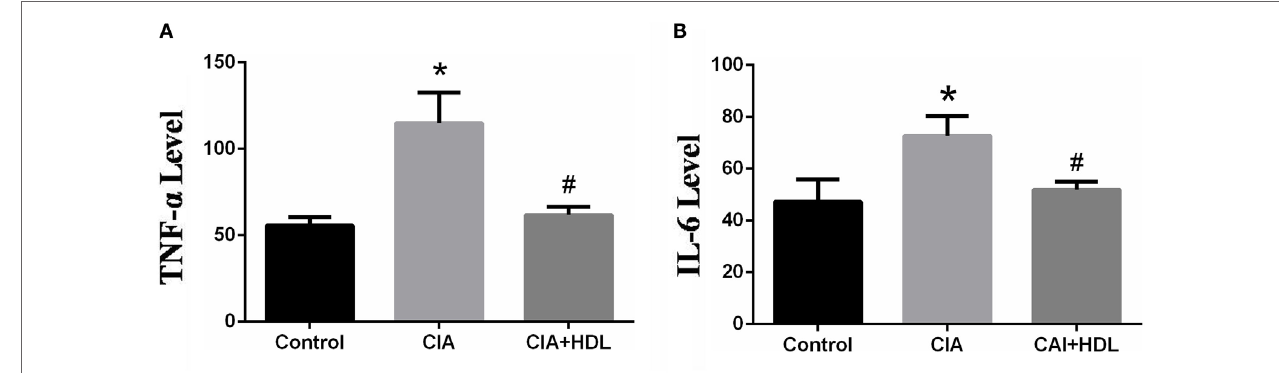
FigUre 2 | (a) The expression of tumor necrosis factor-alpha (TNF- α ) in serum; (B) the expression of IL-6 in serum. * p < 0.05 vs. control; # p < 0.05 vs. collagen- induced arthritis (CIA). The results indicated that the production of pro-inflammatory cytokines TNF- α and IL-6 in mice which received high-density lipoprotein (HDL) decreased 45.14 and 35.02%, respectively.